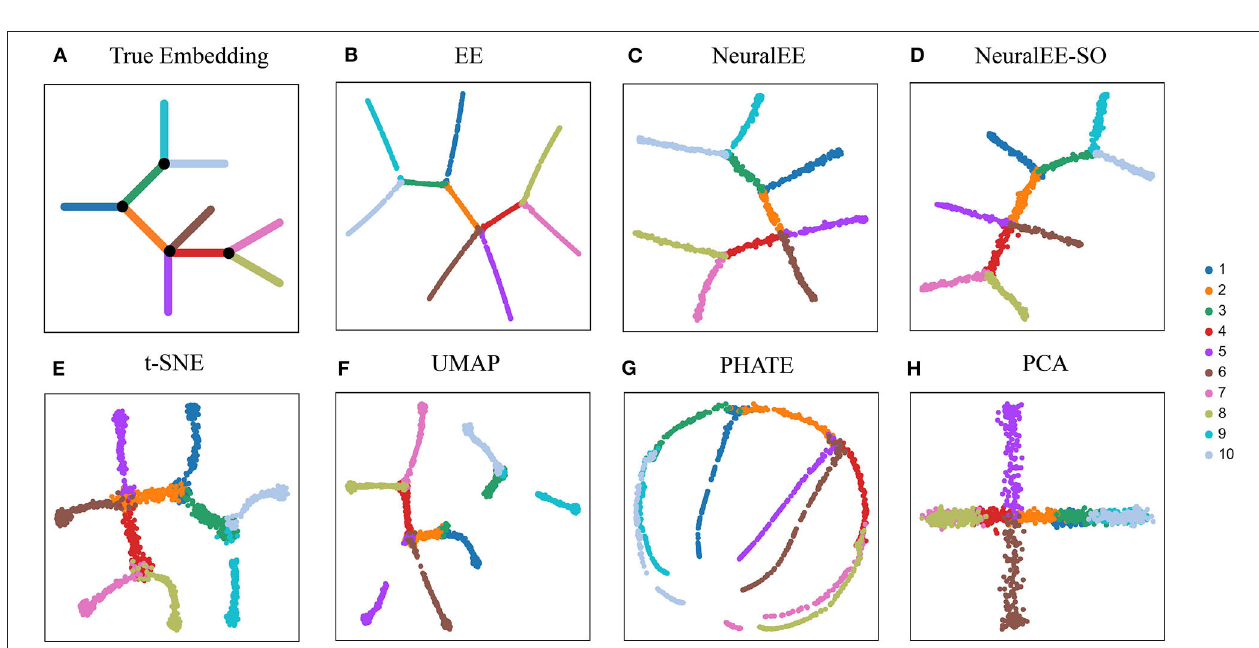
FIGURE 1 | (A) The flow chart of NeuralEE. In brief, NeuralEE constructs an NN that defines a parametric mapping from the original space to the embedded space. The full dataset is first randomly partitioned into several batches (only one batch is also acceptable, which means not applied with mini-batch trick or stochastic optimization). On each batch the attractive weight and the repulsive weight matrices are calculated and fed into the loss function of EE, which is represented as a composite function of the original data. By backpropagation algorithm, the parameters in the NN are optimized, and the mapping of the embedding is thus learned. (B) Visualization results of 1.3 million mouse brain cells by NeuralEE-SO.